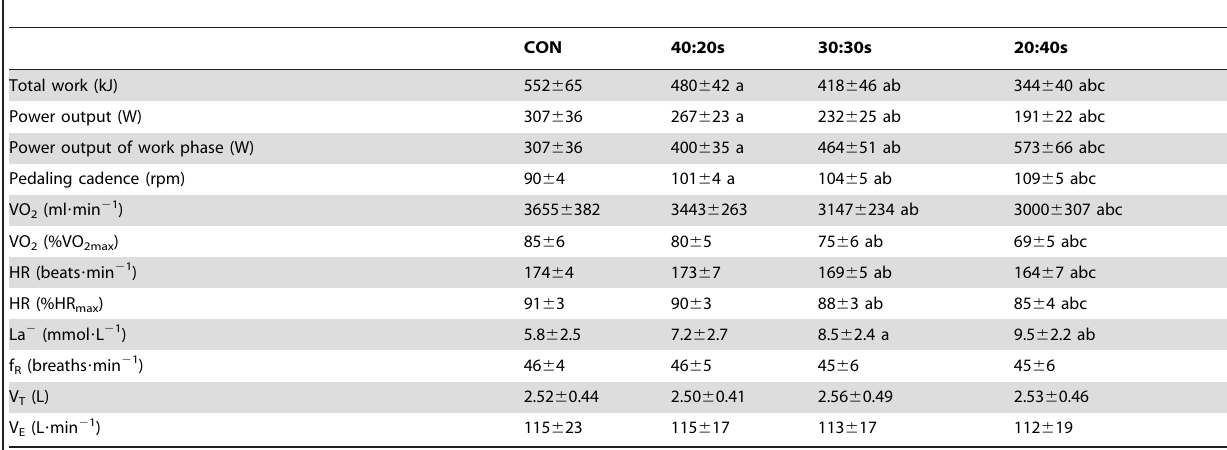
Table 1. Total work and mean values of several performance and physiological parameters for the four experimental protocols.